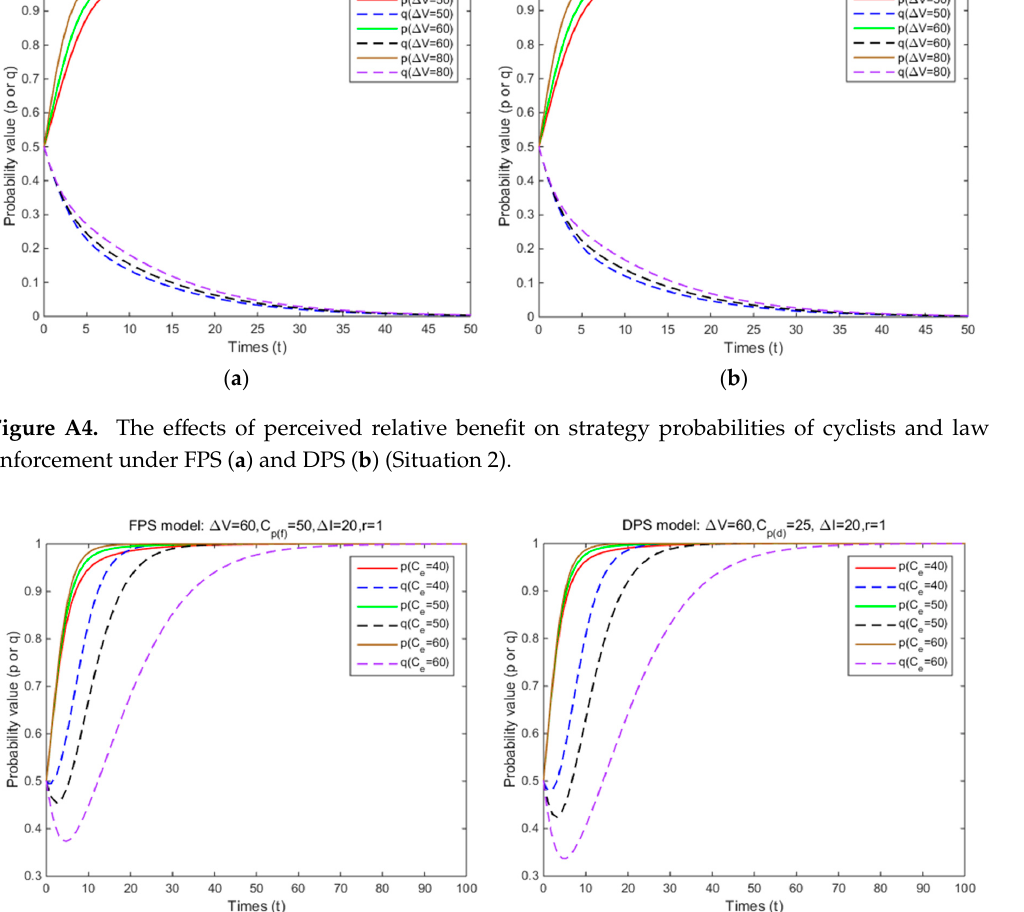
( b ) Figure A6. The effects of enforcement cost on strategy probabilities of cyclists and law enforcement under FPS ( a ) and DPS ( b ) (Situation 2). ( a ) ( b ) Figure A7. The effects of relative public image cost on strategy probabilities of cyclists and law enforcement under FPS ( a ) and DPS ( b ) (Situation 1).